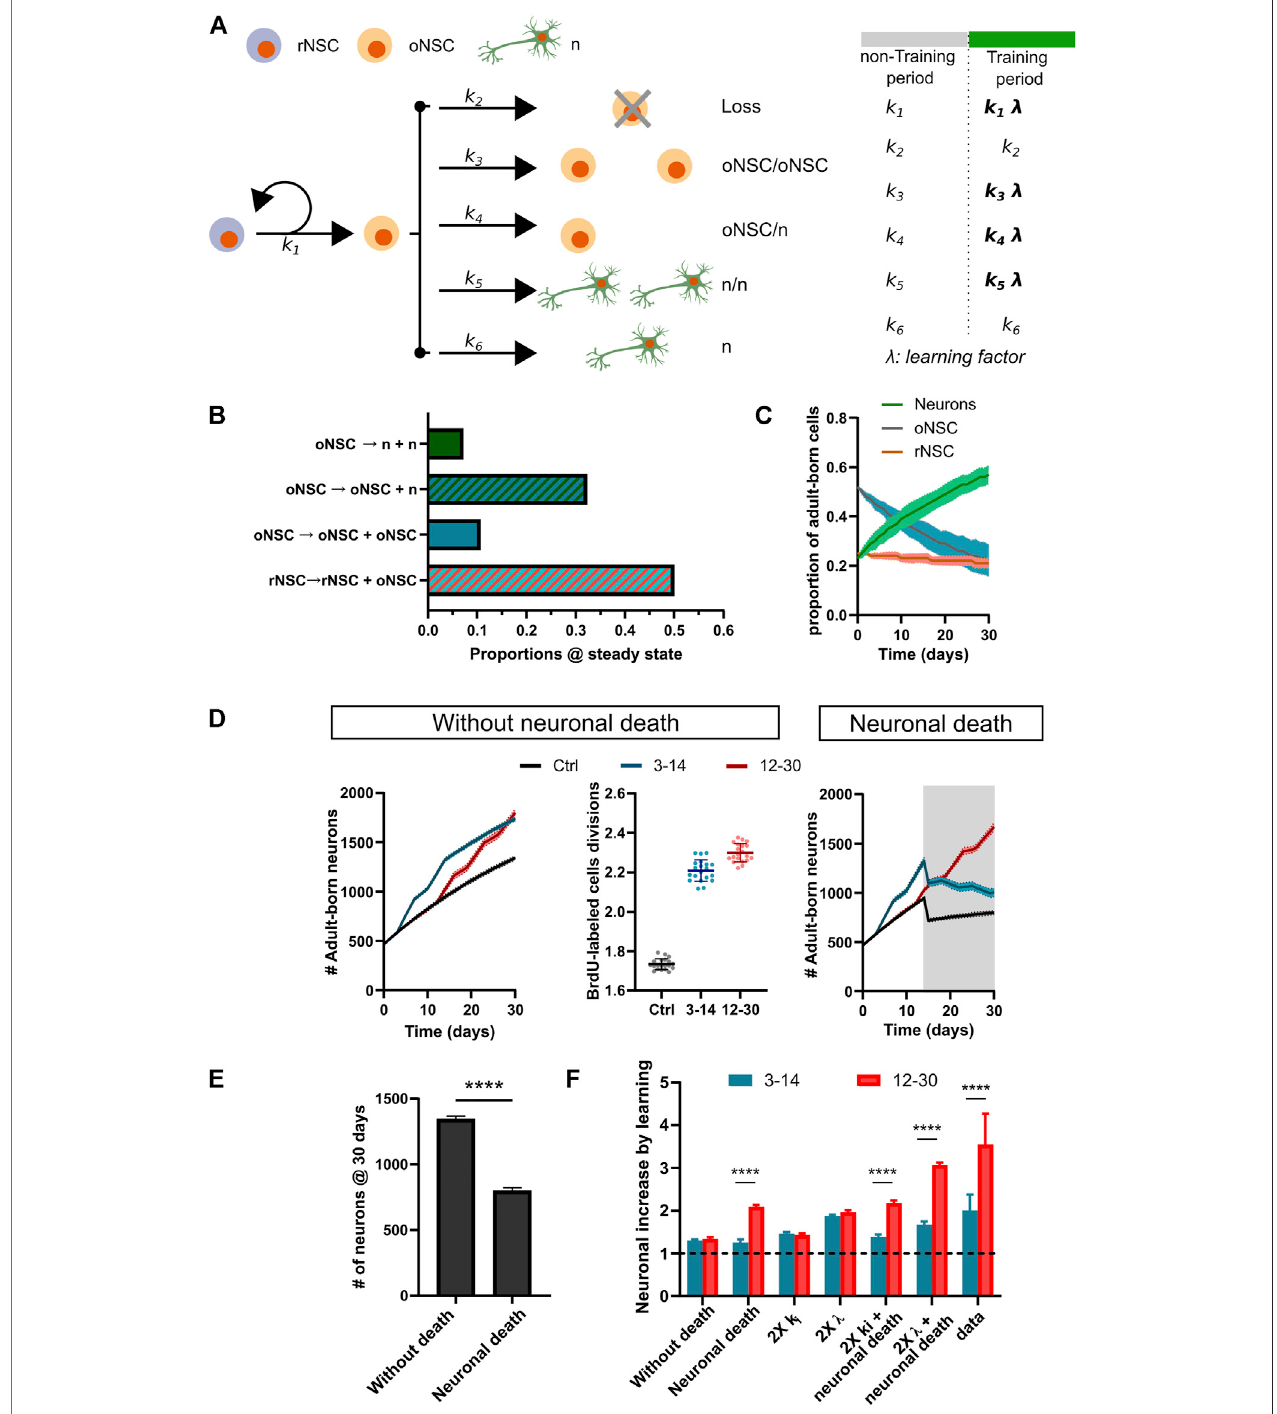
FIGURE 6 | A population NSC dynamics model mimics the learning-induced adult neurogenesis in the rMP. (A) . Scheme outlining NSC population dynamics model. ki indicates rates of division/differentiation. The learning effect on NSC proliferation was simulated by adding a learning factor ( λ ) during training windows. rNSC: reservoir neural stem cell; oNSC: operative neural stem cell; n: neuron. (B) . Number of cellular divisions at steady state, calculated to estimate the initial populations of BrdU-labeled cells. (C) . Population dynamics under Control condition. (D) . Left: Stochastic simulations to estimate the population of adult-born neurons in Control and Trained subjects during two training periods (3 – 14 dpl) and three training periods (12 – 30 dpl). Middle: BrdU-labeled cells division under Control and Training conditions. Right: Stochastic simulations to estimate the population of adult-born neurons considering a checkpoint (at 15 dpl) for neuronal death, together with a learning-induced rescue. (E) . Adult-born neurons for Control subjects at 30 dpl, with and without neuronal death (Unpaired t -test, t (38) = 73.10, **** depicts p < 0.0001, N = 20). (F) .Neuronalincreasebylearningunderdifferentconditions(Two-wayANOVA,Periodeffect:F (6,239) =430.7with p < 0.0001,Conditioneffect:F (1,239) =1,342with p < 0.0001. Post-hoc Sidak ’ s test **** depicts p < 0.0001- N = 20 for simulation, N = 5 for data).